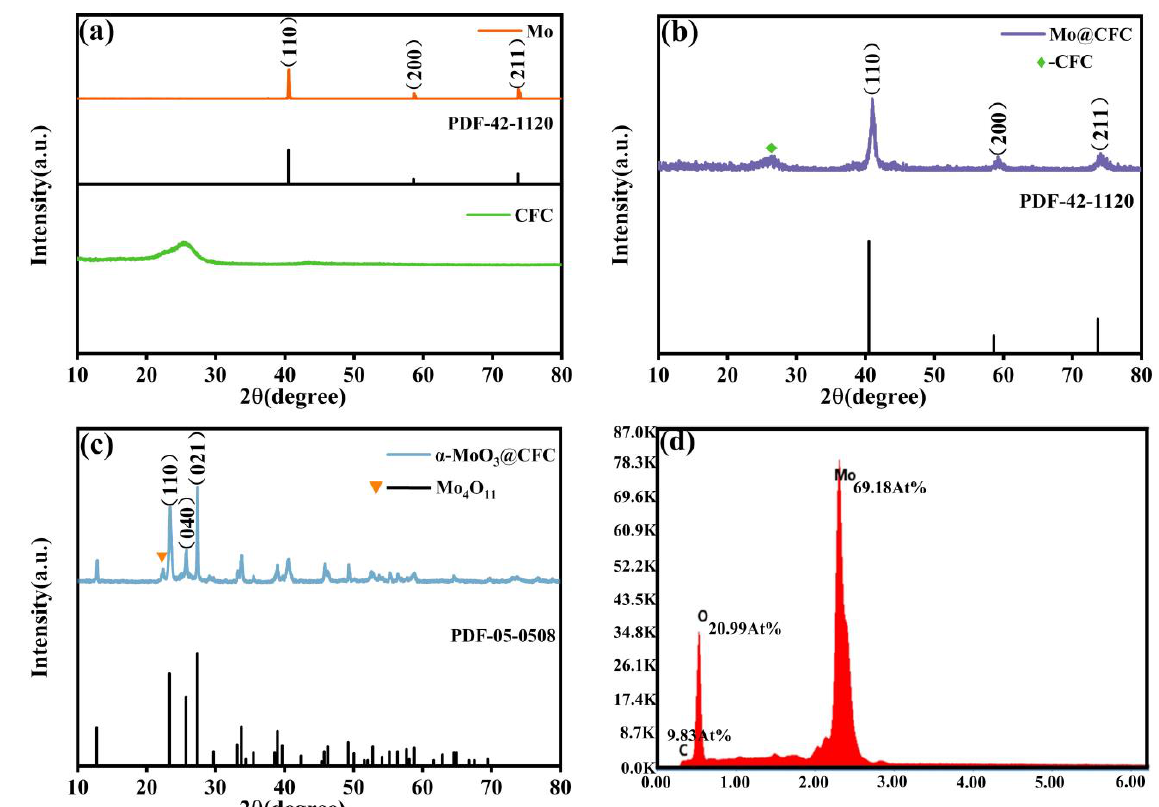
Figure 2. The patterns of X-ray diffraction for ( a ) Mo powder and pure CFC, and ( b ) Mo@CFC; ( c , d ) X- ray diffraction and EDS of α -MoO 3 @CFC. ( c , d ) X-ray diffraction and EDS of α -MoO 3